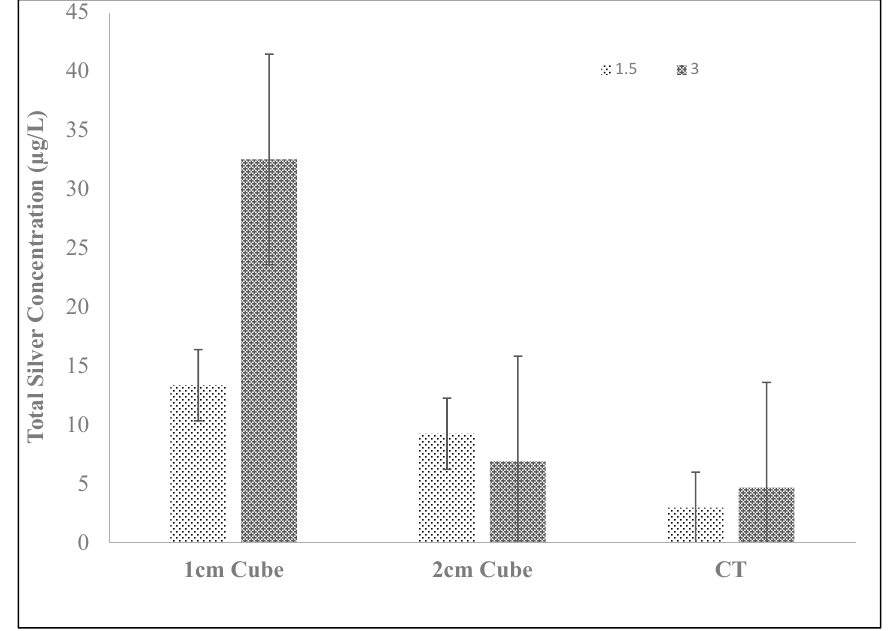
Figure 10. Total silver concentration in a 10 L water volume for 1 and 2 cm cubic silver ceramic media and full-size ceramic tablets (CT) after a 24 h equilibration period. Total silver-ceramic masses studied are 1.5 and 3.0 g. Error bars represent standard error of replicate measurements .